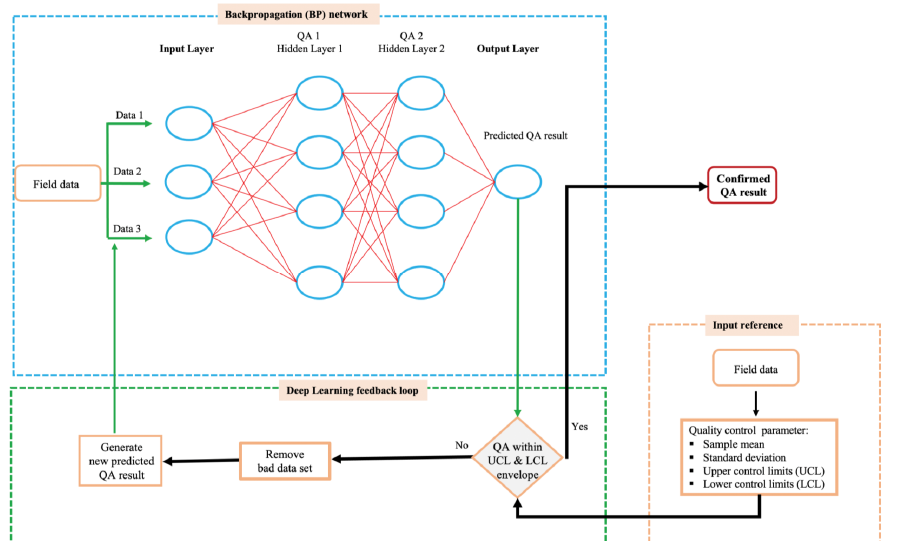
Figure 14. Network diagram of the BP artificial network used to predict QA results, input reference, and deep learning feedback loop. There are three input nodes (left): Data 1 includes GPS coordinates, time, and altitude; Data 2 is gain settings for each unit and channel; and Data 3 is the operator’s name. This BP artificial network has two hidden layers: QA 1 includes robust processing parameters: root mean square (RMS) error, phase behavior, and apparent resistivity. QA 2 includes 1D inversion result like root mean square fit (RMSf) error. The outputs are the predicted QA results. They will get compared with actual QA results. Input layer reference generates quality control parameters from field data and define upper control limit (UCL) and lower control limit (LCL). Predicted QA results from BP network will get checked as to whether they’re within UCL and LCL envelope; if not, the bad data set will be removed, and new predicted QA result will be re-generated by BP network.